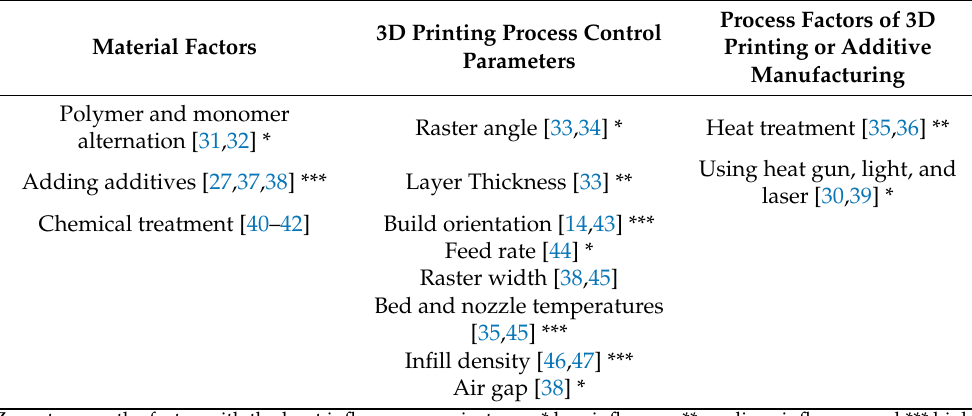
Table 1. Anisotropy control factors and